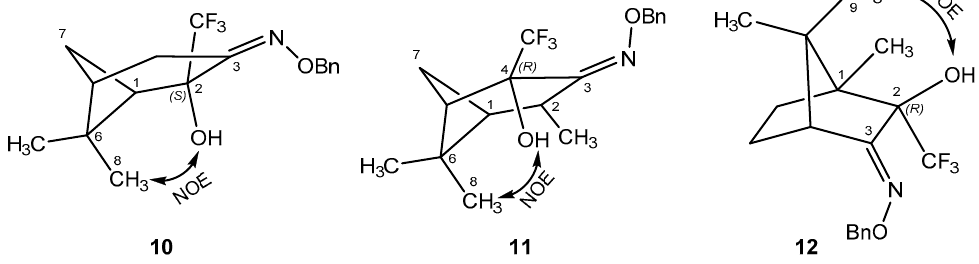
Figure 1. Structure and NOE interactions of compounds (2 S )- 10 , (4 R )- 11 , (2 R )- 12 . Trifluoromethylated benzyl- O -oximes 10 – 12 based on (+)-nopinone, ( − )-verbanone and (+)-camphoroquinone were reduced with LiAlH 4 to the corresponding amines isolated as hydrochlorides 13 – 15 in 81–95% yields (Scheme 3).